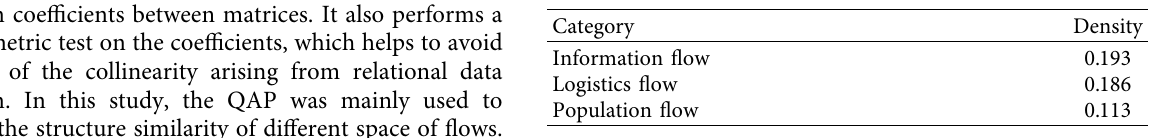
Table 1: Overall network density of the three